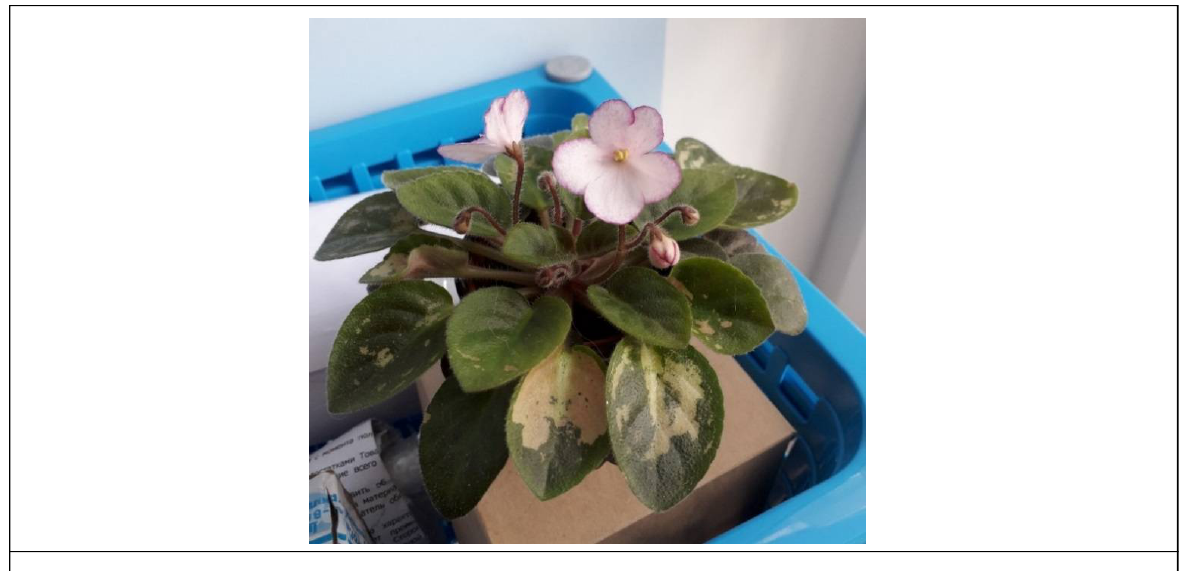
Figure 1: Before the start of the experiment (March 2, 2019)